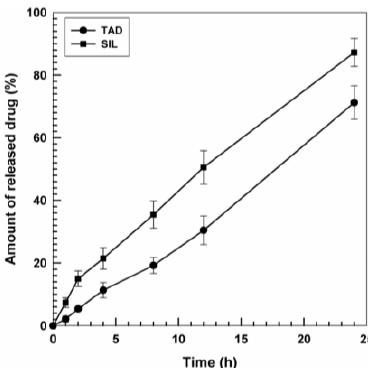
Figure 2. Release profile of SIL and TAD from nanoliposomes. Experiments were carried out at room temperature. Values were the mean of three independent experiments in triplicate ± standard deviation (SD).